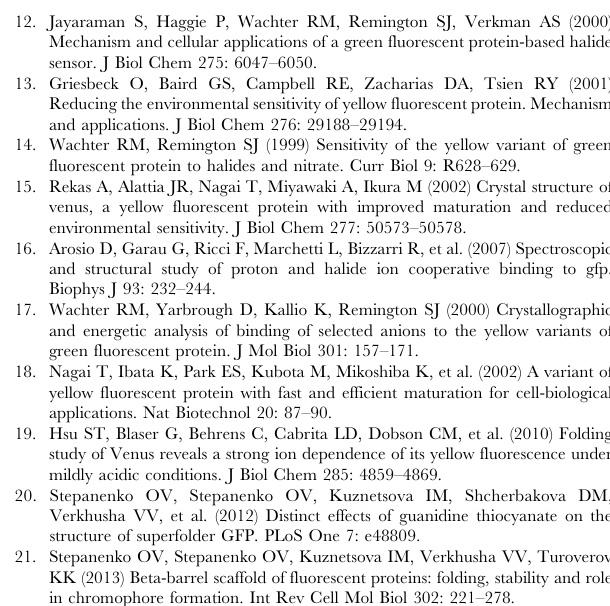
Figure S2. Ionic denaturant and salt effects on spectral features of sfGFP. The changes in tryptophan fluorescence spectra at an excitation wavelength of 297 nm (first column) and the changes in green fluorescence spectra of sfGFP at excitation wavelengths of 390 nm (second column) and 490 nm (third column). Agents used were ionic denaturants, such as GTC and GdnHCl, and salts, such as NaSCN and NaCl. Applied agent concentrations are indicated on the right of the figure. Figure S3. Conformational changes in sfGFP induced by studied agents. ( A ) Changes in parameter A= I 320 / I 365 , l ex =297 nm ( B ) Changes in fluorescence anisotropy at an emission wavelength of 365 nm and excitation wavelength of 297 nm. Agents used were GTC (red circles) and GdnHCl (blue circles), NaSCN (pink circles) and NaCl (green